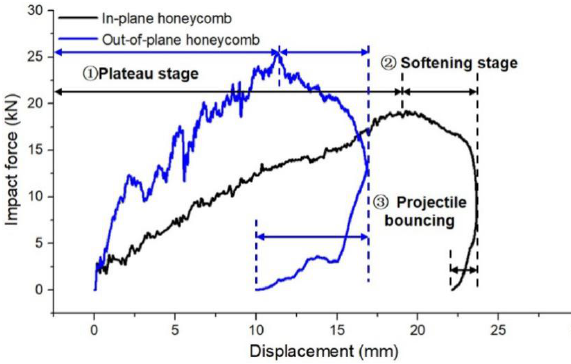
Figure 8: Comparison of impact force-displacement curve in terms of sandwich panel with in-plane and out-of-plane